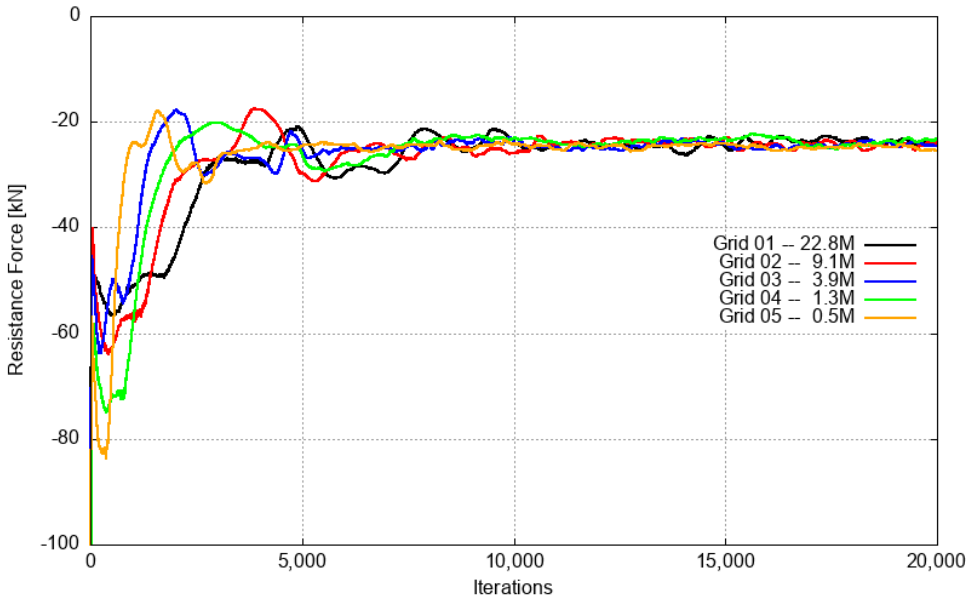
Figure 12. Convergence of forces in CFD simulations for H / D = 0.347 and Fr = 0.194.